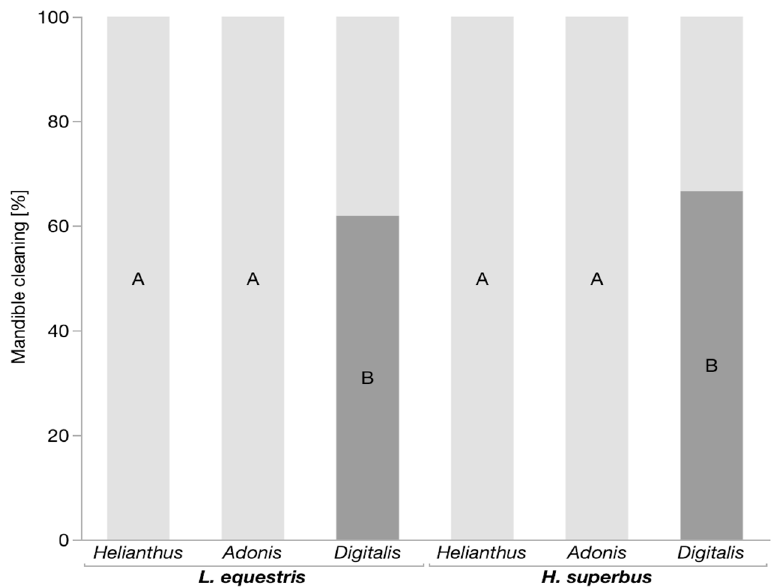
Figure 2. Mandible cleaning behavior shown by C. carnea after attacking milkweed bug larvae. Bars represent the proportion of lacewing larvae that cleaned their mandibles (dark grey) and that did not clean their mandibles (light grey) after attacking L. equestris (n = 22–26 per treatment) and H. superbus (n = 15–16 per treatment) larvae raised on the seeds of either Helianthus annus (sunflower), Adonis vernalis or Digitalis purpurea . Within the same insect species, levels not connected by the same letter are significantly different.